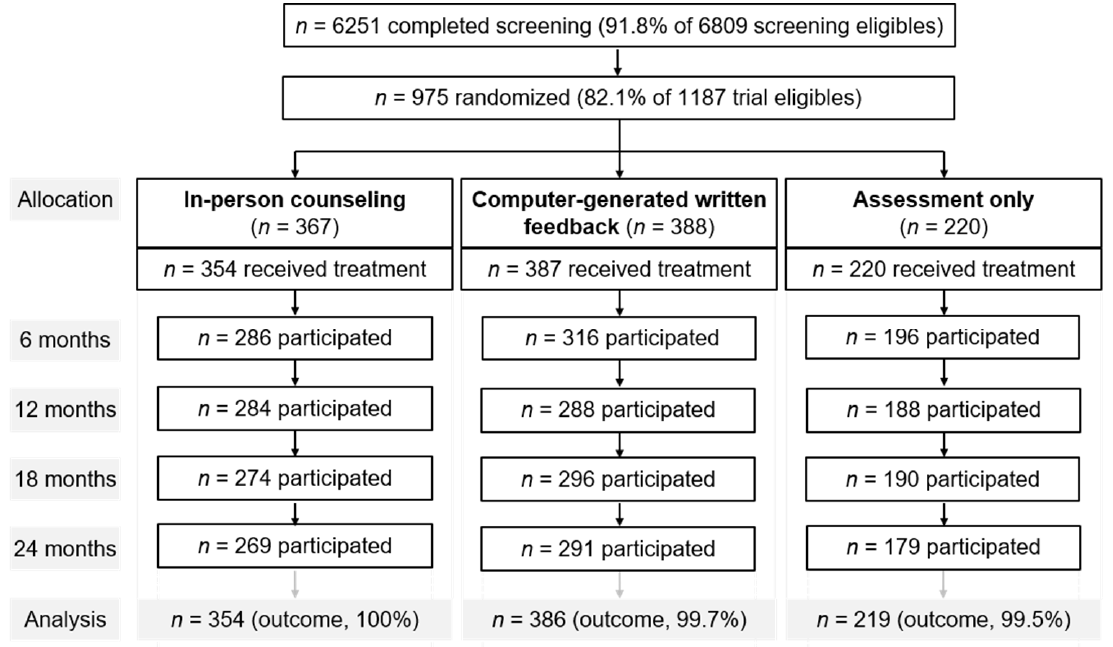
Figure 1. Participant flow by the study group.